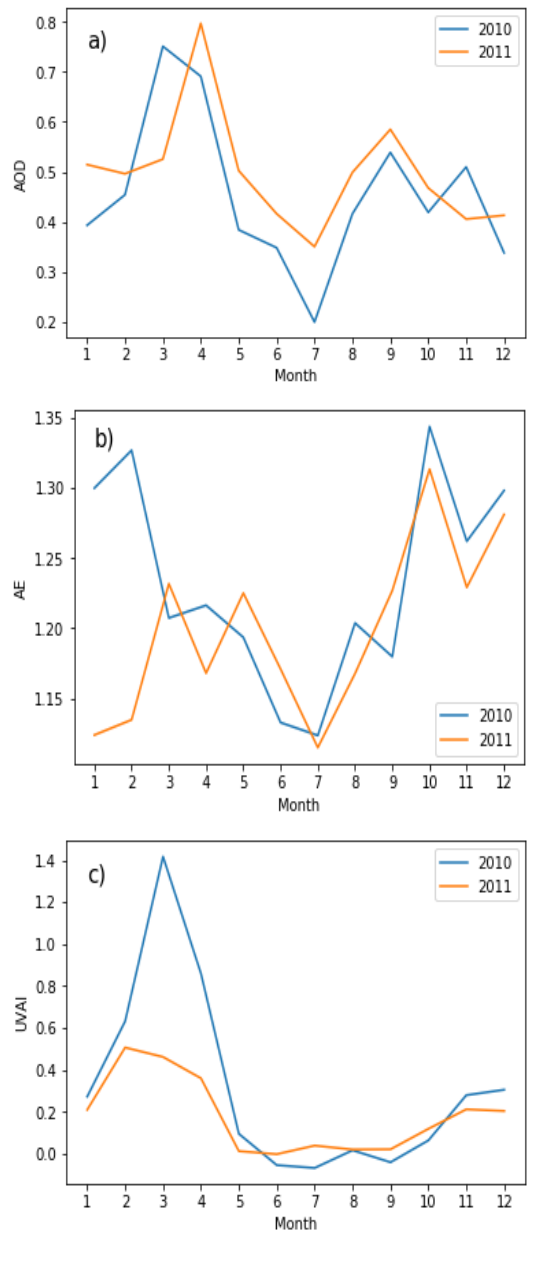
Figure 1. Temporal variation of 2010 and 2011, (a) AOD, (b) AE, (c) UVAI